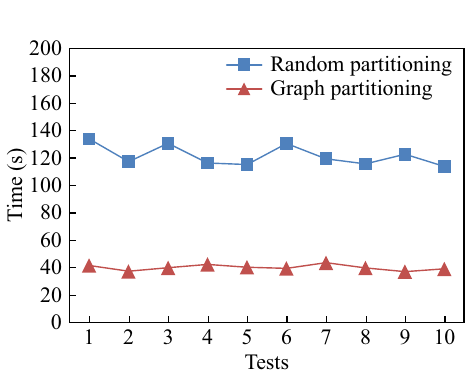
Fig. 13 Effects of two fragmentation strategies on querying time.